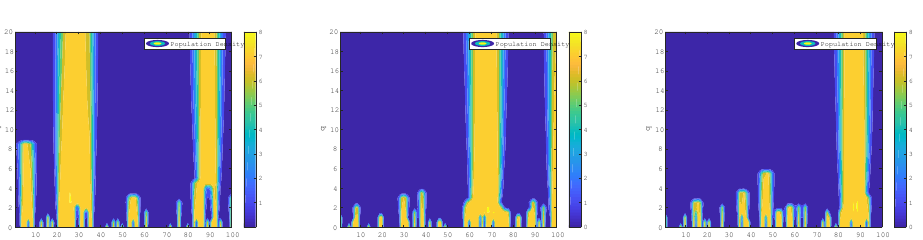
Figure 14. Same as in Figure 13 but for β = 7.